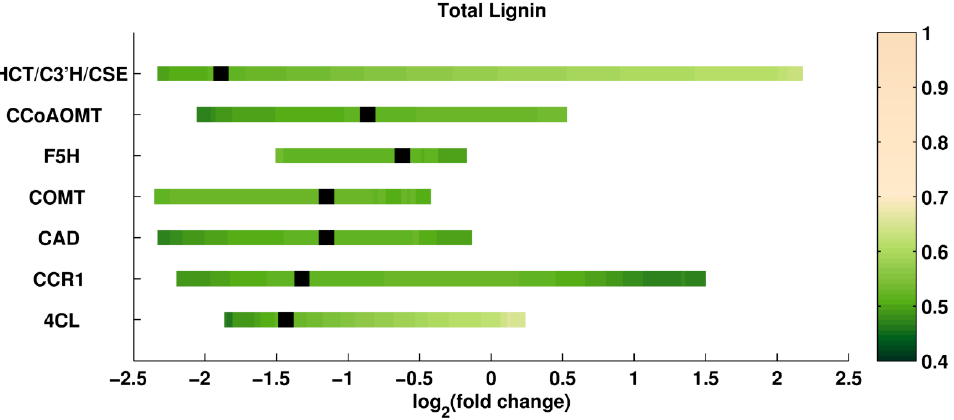
Figure 6. Total lignin in overexpressed PvMYB4 plus a single enzyme perturbation. The color code is the same as in Figure 2. The black squares represent the original amount of the corresponding enzyme in the PvMYB4 experiment. Additional overexpression of CCR is predicted to improve the total lignin results. Decreasing the level of CAD and CCoAOMT, relative to the reference PvMyb4 experiment, can reduce the total lignin further.